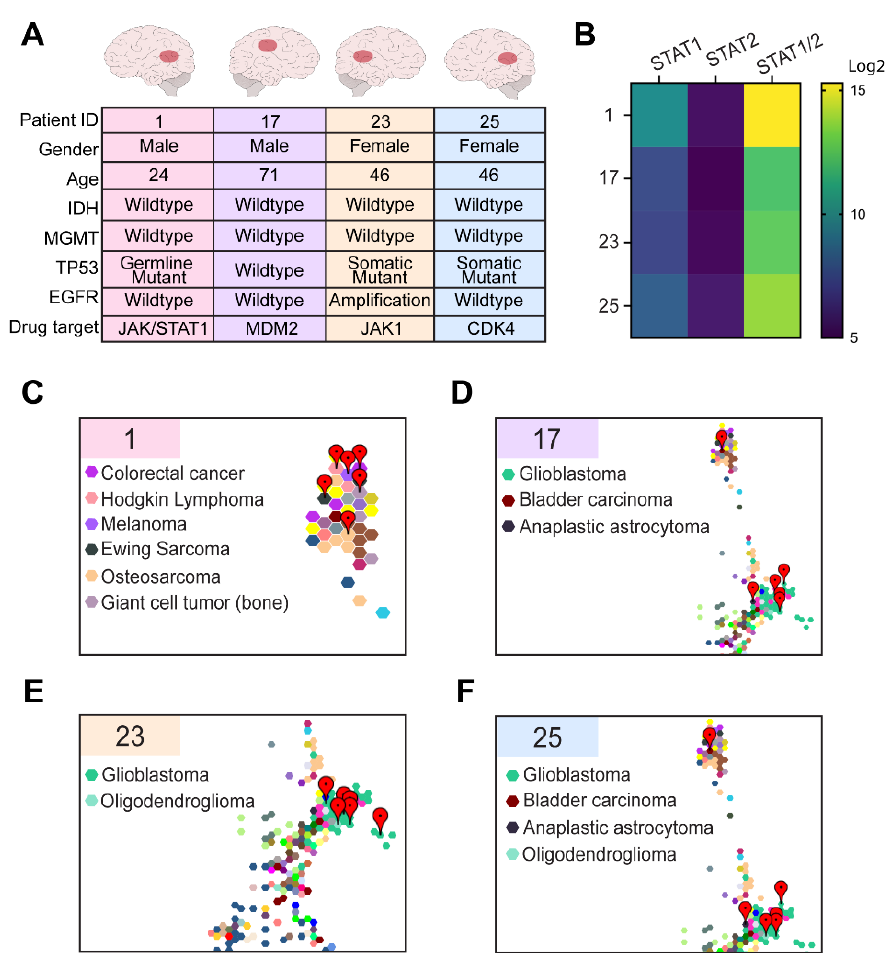
Figure 4. Selected patient ‐ derived cell cultures were characterized prior to functional validation. ( A ) Table identifying tumor location, sex, age, mutation status, and predicted drug targets for the four selected patient cell lines. ( B ) Heatmap identifying STAT1 and STAT2 expression for each of the four patient cell lines with combined value shown. TumorMap analysis of selected patient cell lines; Patient 1 ( C ), Patient 17 ( D ), Patient 23 ( E ), and Patient 25 ( F ) with red markers highlighting each